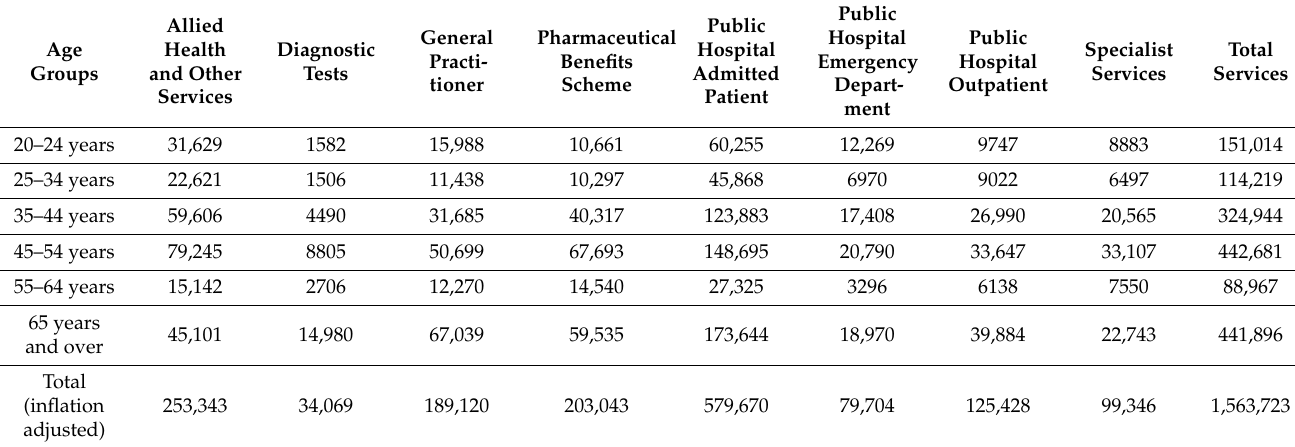
Table A10. Extra costs incurred due to LHL for people diagnosed with Mental illness in the Blacktown LGA (Domain 9). Allied Age Health Groups